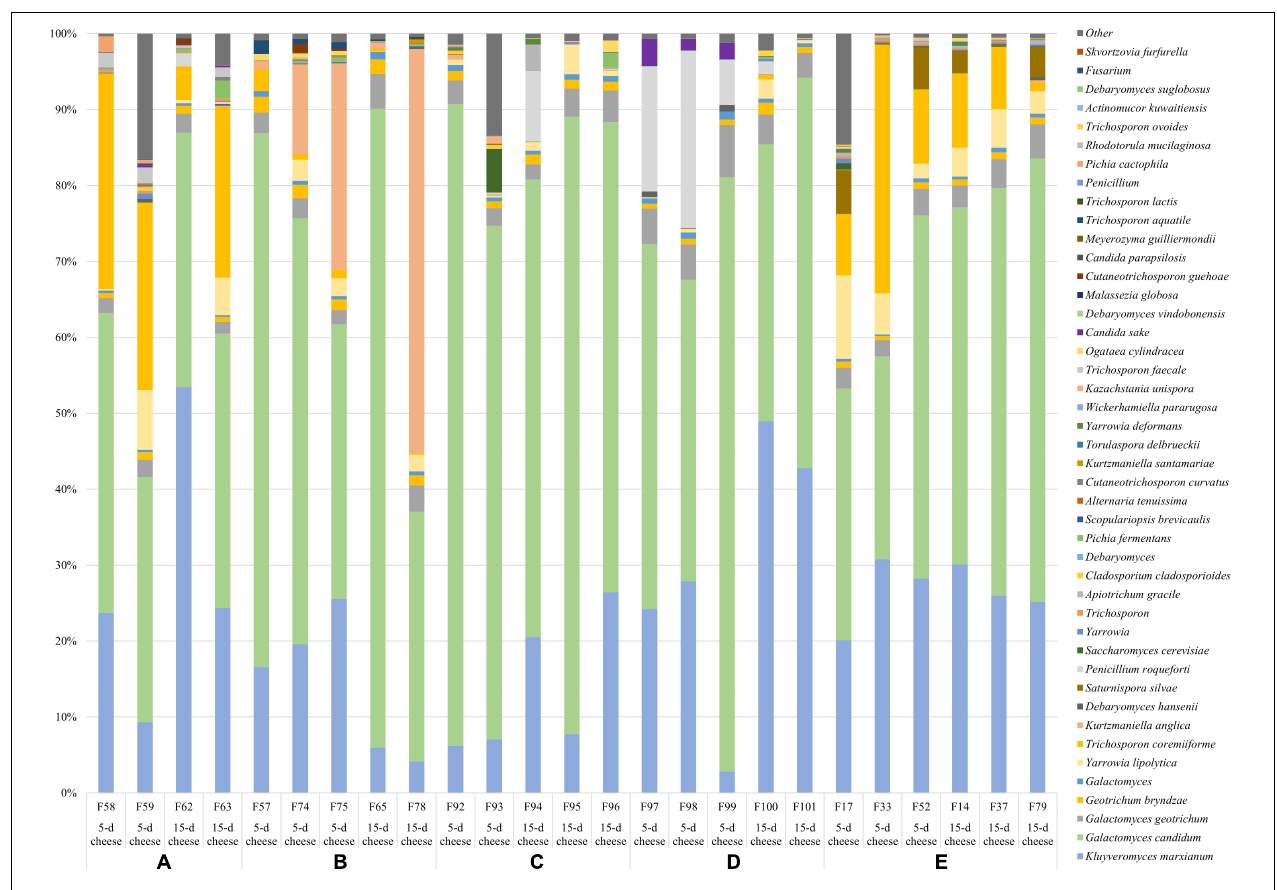
FIGURE 5 | Relative abundance (%) of the taxa detected with 26S sequencing. Only ASVs with an incidence at least 0.5% in at least two samples are